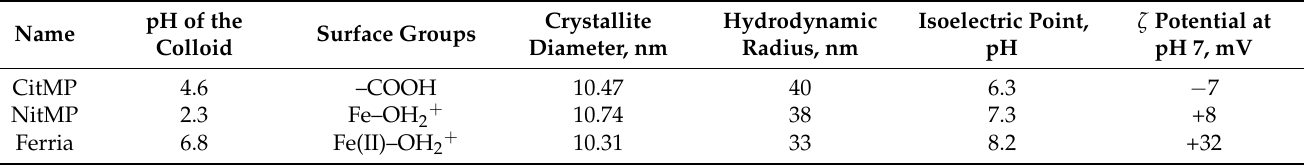
Figure 1. Magnetite nanoparticles in this study. SEM image and XRD pattern of Ferria ( a , d ), NitMP ( b , e ), and CitNitMP ( c , f ). ( g ): Zeta potential at various pH levels for all synthesized hydrocolloids. The comparative characteristics of the used systems can be seen in Table 1. Table 1. Magnetite hydrosols used in this